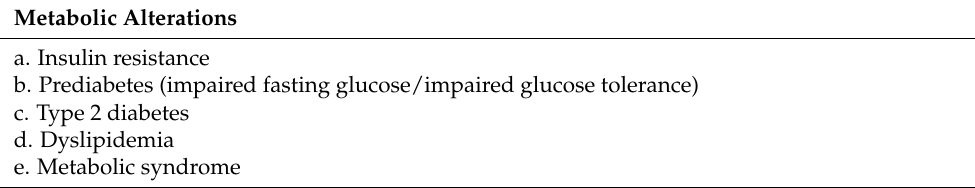
Table 1. Metabolic alterations and cardiovascular comorbidities in obese children and adolescents.